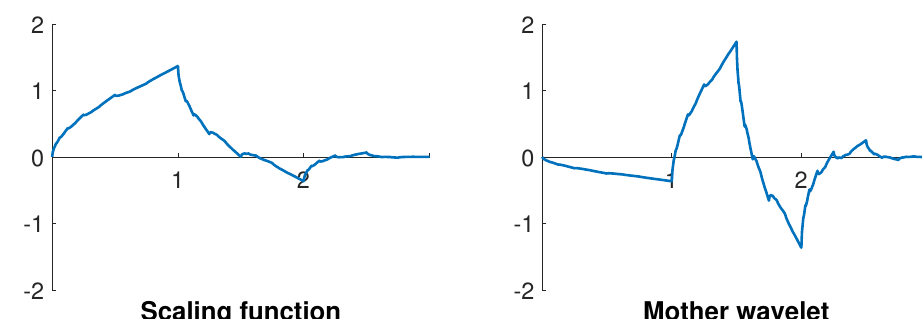
Figure 1. Scaling function and mother wavelet of the fourth-order Daubechies